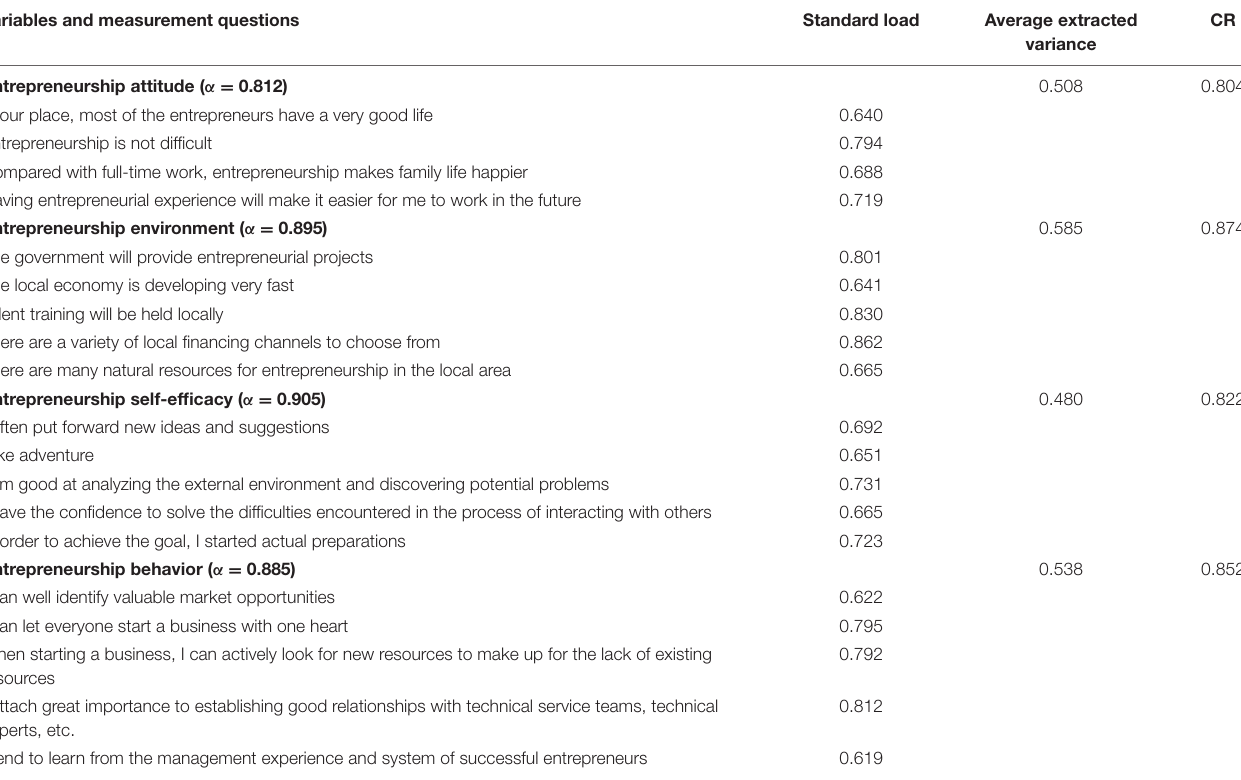
TABLE 2 | Test results of reliability and validity of